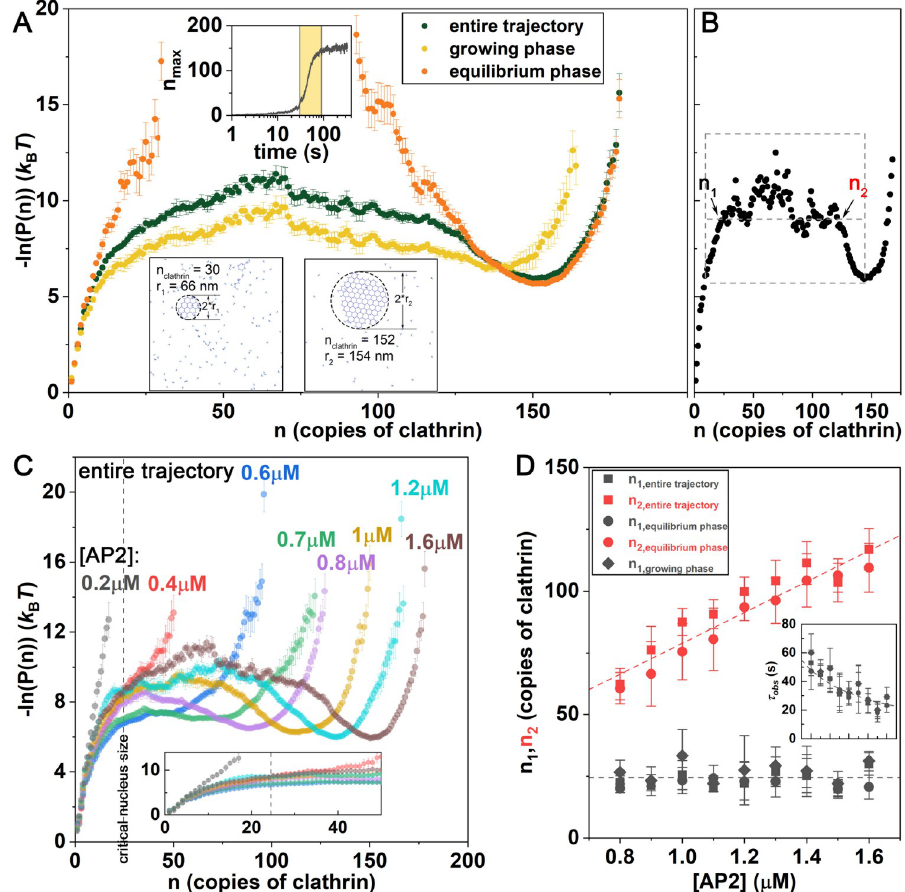
Fig 5. Clathrin lattices start as monomers that face an initial barrier to growth, with a stable size reached only after significant growth. (A) The probability of observing clathrin lattices of size n can be converted to an energy-like metric − ln ( P ( n )), which at equilibrium is a true free energy in units of k B T . An initial barrier (in n ) to nucleation plateaus, followed by a relatively flat region, where structures have comparable probability. Across the full time- dependent trajectory shown in the upper inset, we analyze lattices sampled across the full trajectory (green dots), the growth phase (yellow dots), and equilibrium (orange dots). During growth, clathrin forms intermediate size lattices, while at equilibrium, only small and large lattices are visible. [AP2] = 1.6 μ M. (B) To quantify the end of the initial barrier to growth ( n 1 ), and the start to the stabilized growth (n 2 ), we define a plateau at constant − ln ( P ( n )) that defines these intercepts for each trajectory (Text A in S1 Text). (C) With increasing adaptor concentration, larger lattices become stabilized. The shape of the curves are consistent with the data in Fig 4A; the free energy forms a trough at higher concentrations, consistent with the average size of lattices at equilibrium. (D) The critical size where the barrier plateaus is ~ n 1 = 25, independent of adaptor concentration. The noisy plateau region is followed by a well that starts at n 2 and increases with increasing adaptor concentration. (Inset) With higher adaptor concentration, the time to cross the first barrier at n 1 is faster, following the inverse of adaptors τ obs / 1/[AP2], with a proportionality constant 1/ [0.026 μ M -1 s -1